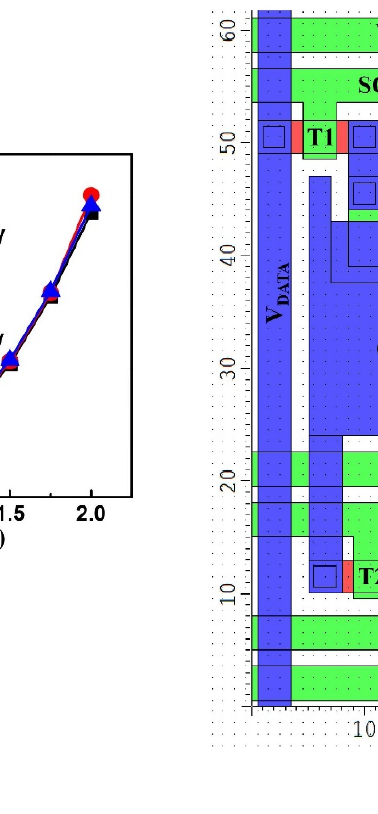
Figure 7. ( a ) OLED current versus data voltage with V TH shift of the driving TFT, V TH_OLED shift of OLED degradation, and I-R drop of V DD . ( b ) Layout of the proposed 5T2C pixel circuit.